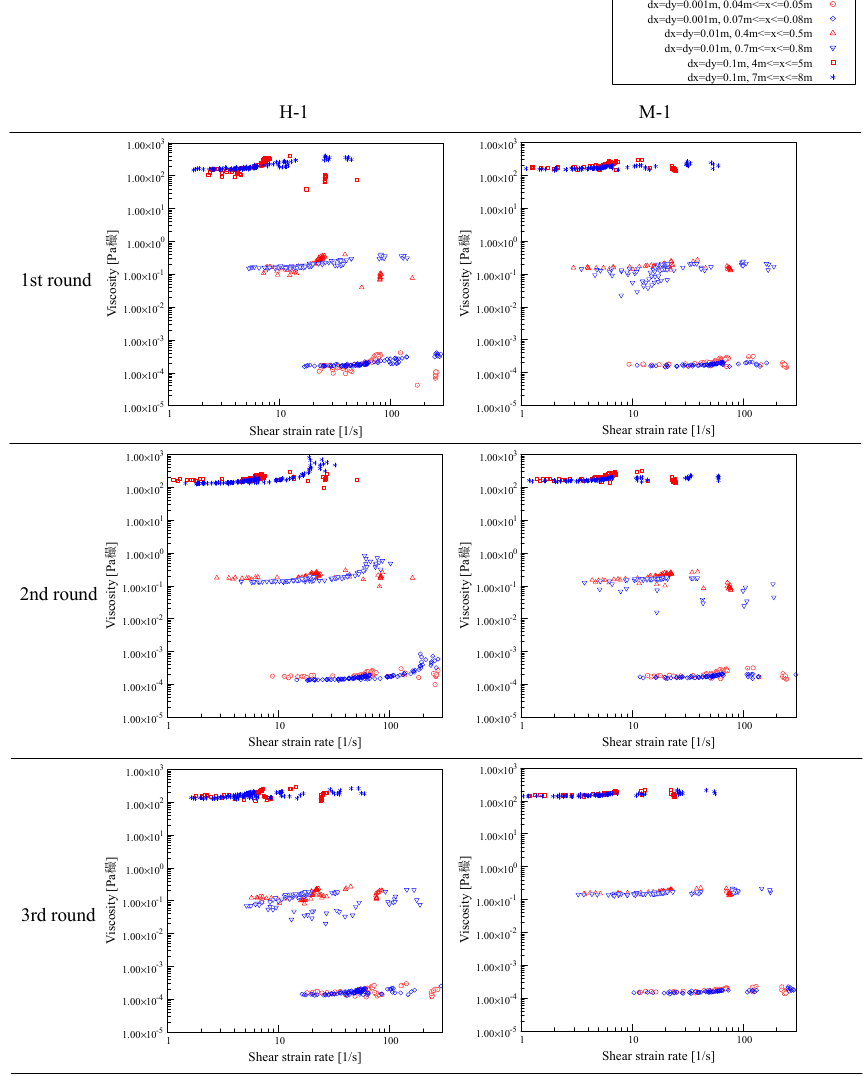
Figure 27. Relationship between the shear strain rate and the viscosity coefficient from the simulation results. The red mark shows 0.04 to 0.05 m as the deceleration range, and the blue mark shows 0.07 m to 0.08 m as the acceleration region.